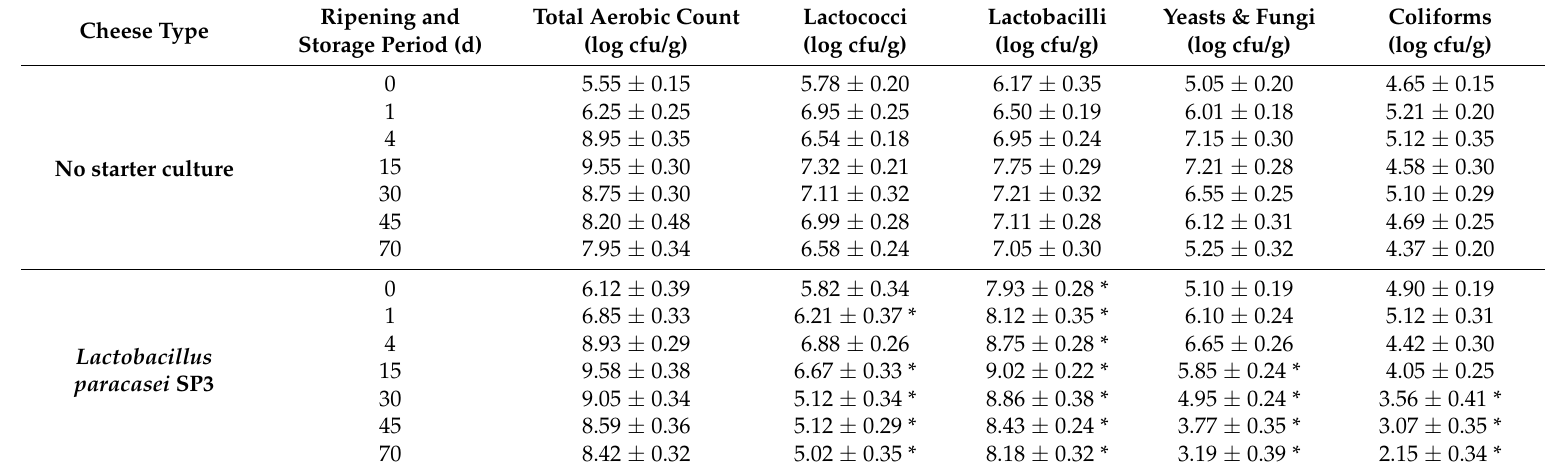
Table 4. Effect of Lactobacillus paracasei SP3 on major microbial groups of Feta-type